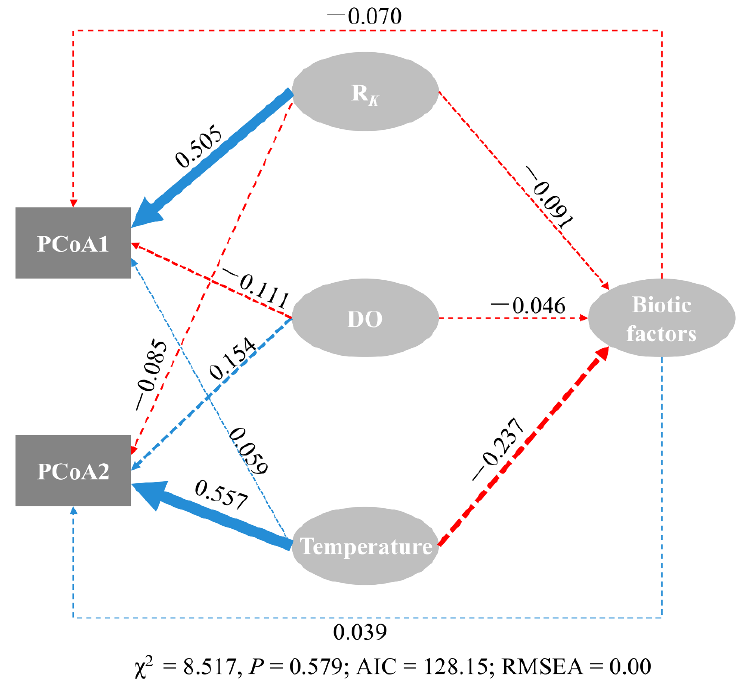
Figure 3. Directed graph of the structural equation modeling (SEM). Each oval shape represents an observed variable (i.e., measured) and latent variable (i.e., constructs). The loading for principal coordinate analysis (PCoA) scores of ciliate communities that create the latent variables are shown in the rectangle. Path coefficients are calculated after 1000 bootstraps and reflected in the solid width of the arrow, with blue and red indicating positive and negative effects, respectively. Dashed arrows show that coefficients did not differ significantly from 0 ( p > 0.05). The model is assessed using the maximum likelihood ( χ 2 ) goodness-of-fit test with p -values, Akaike information criteria (AIC), and the root mean square error of approximation